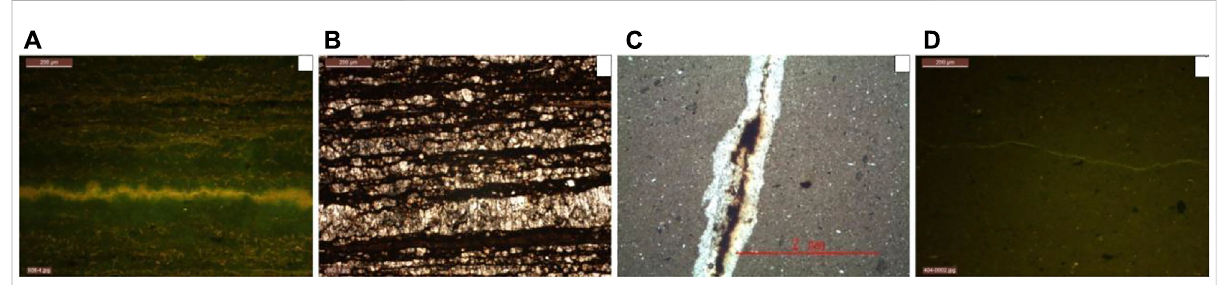
FIGURE 8 Microscopic characteristics of microcracks. (A) Along the layer of microcracks, bright yellow fl uorescence. (B) Overpressure crack is fi lled with brightcrystalcalcite. (C) Calcitehalf- fi lling,highAngleinclinedintersectionjointcontainsoil. (E) Graymudstone,un fi lledwithmicrocracks,produces green